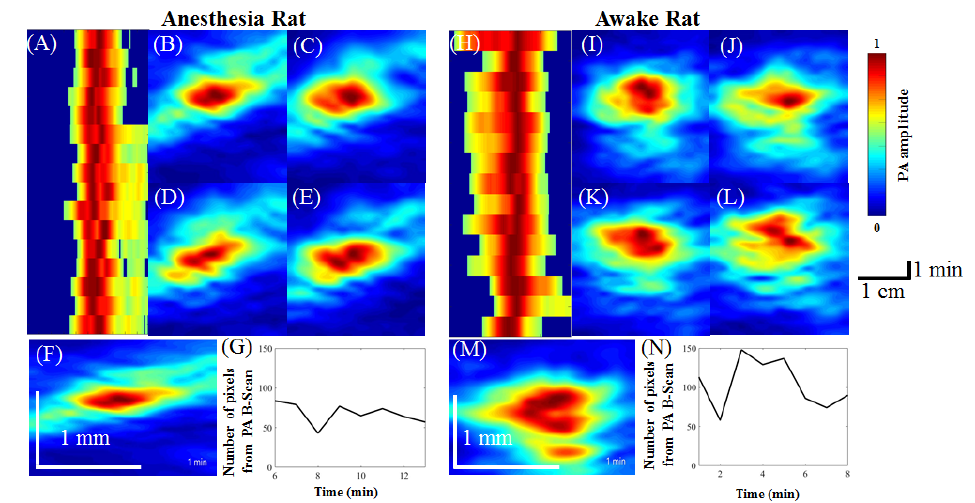
Figure 8. PA B-scan monitoring of the dynamics of the selected SSS blood vessel in anesthetized and awake rats. ( A ) PA MAP image of the time course of vessel diameter changes in anesthetized rats. The x -axis indicates the PA B-scan image, and the y-axis indicates the scanning time. The scanning time in this representative illustration is 16 min. ( B – E ) PA B-scan cross-sectional images of the target blood vessel at 1, 4, 9, and 14 min of anesthesia. ( F , G ) Video of the PA B-scan images and the number of pixels in PA B-scan images of anesthetized rats at different time points (16 min in total) (Movie S5). The number of pixels in the PA B-scan images of the measured SSS blood vessel ranged between 45 and 135. ( H ) PA MAP image of the time course (16 min) of blood vessel diameter changes in awake rats. The x -axis indicates the PA B-scan image, and the y -axis indicates the scanning time. The scanning time in this representative illustration is 16 min. ( I – L ) PA B-scan cross-sectional images of the target SSS blood vessel in an awake rat at 4, 6, 8, and 14 min. ( M , N ) PA B-scan images and the number of pixels in PA B-scan images of anesthetized and awake rats at different time points (16 min in total) (Movie S5). The number of pixels in the PA B-scan of the measured SSS blood vessel ranged between 58 and 148.